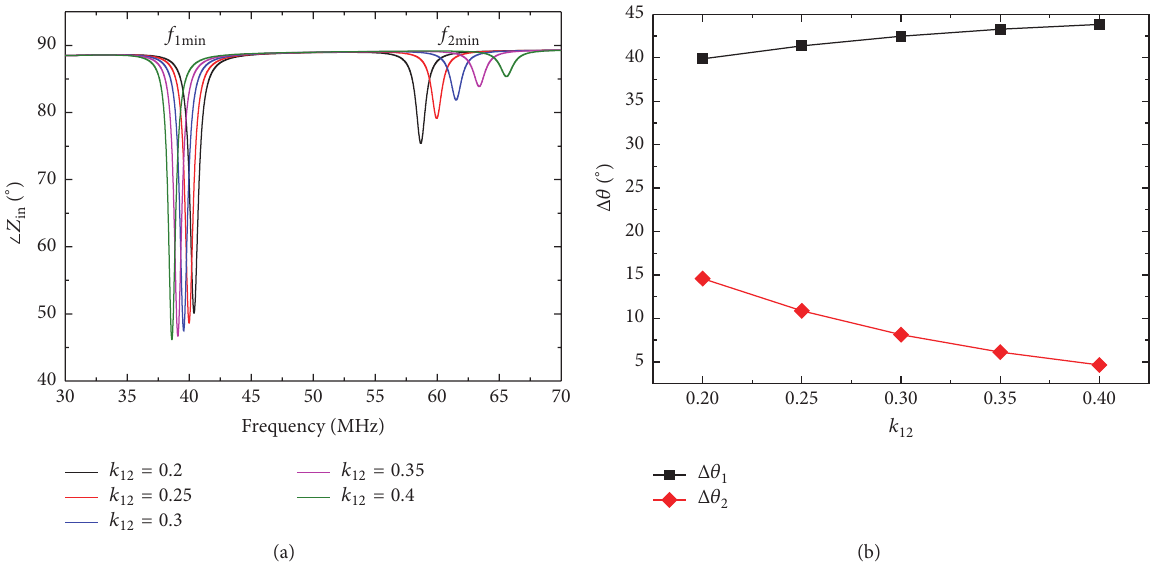
Figure 7: (a) Phase versus frequency curve of the readout coil when the coupling coefficients 𝑘 12 increased and (b) the influence of 𝑘 12 on the value of Δ𝜃 1 and Δ𝜃 2 .